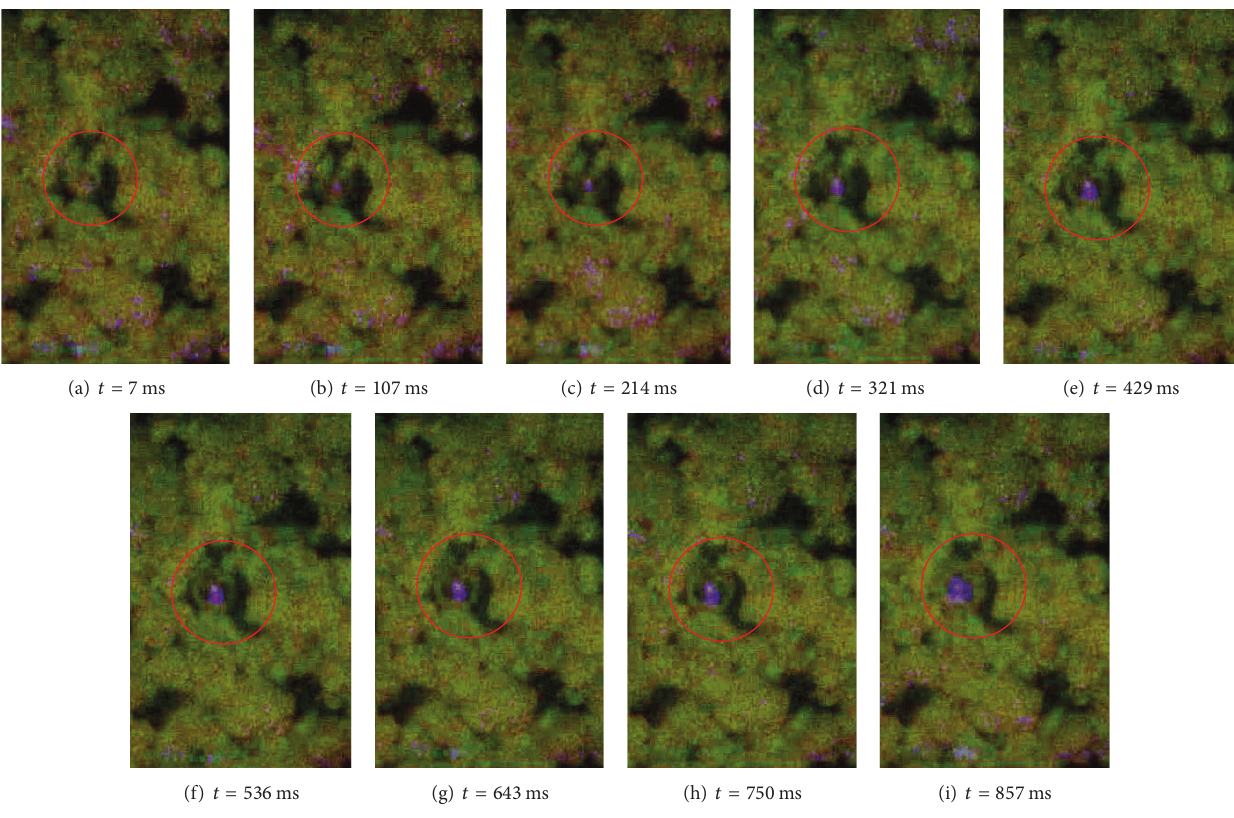
Figure 4: Hydrogen bubble evolution process.